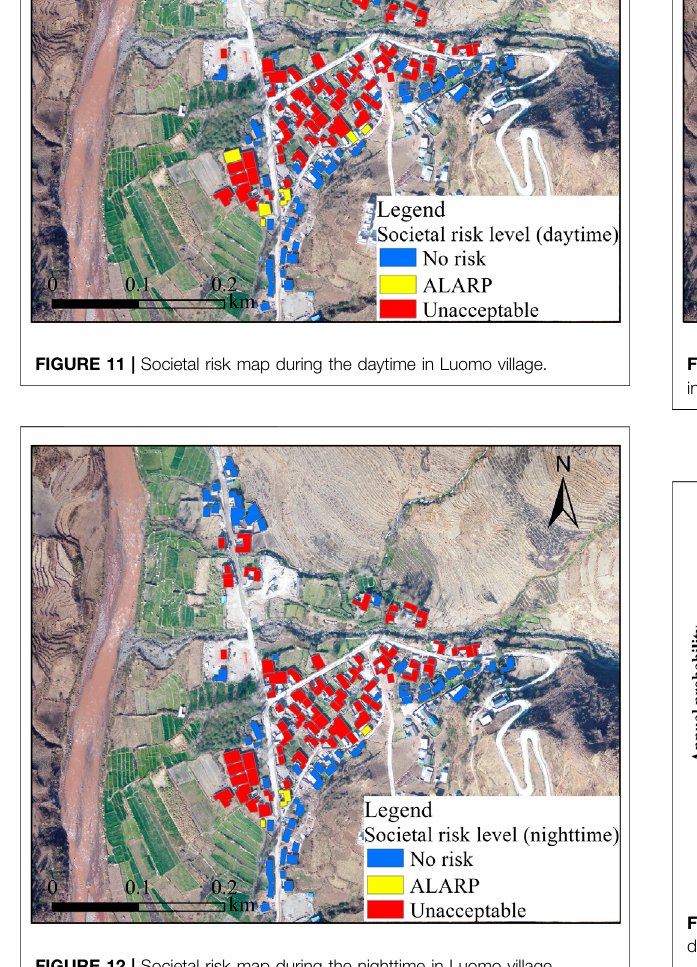
FIGURE 12 | Societal risk map during the nighttime in Luomo village.